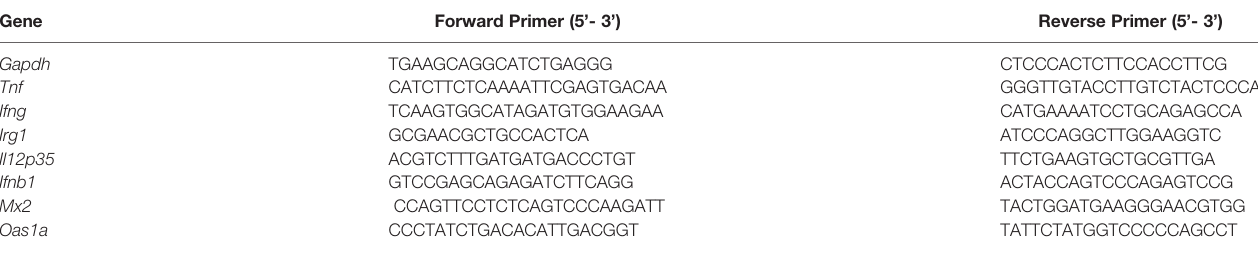
TABLE 1 | Sequences of PCR primers